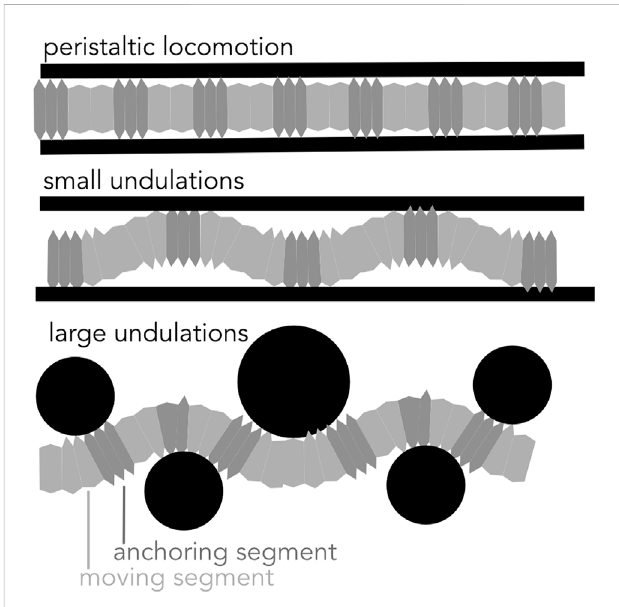
FIGURE 9 Diagram of peristaltic and undulatory movements. Soft-bodied burrows create anchors to generate thrust in a cylindrical burrow using peristaltic expansionsand small undulations. Larger undulations result in a meandering path and are effective in moving around